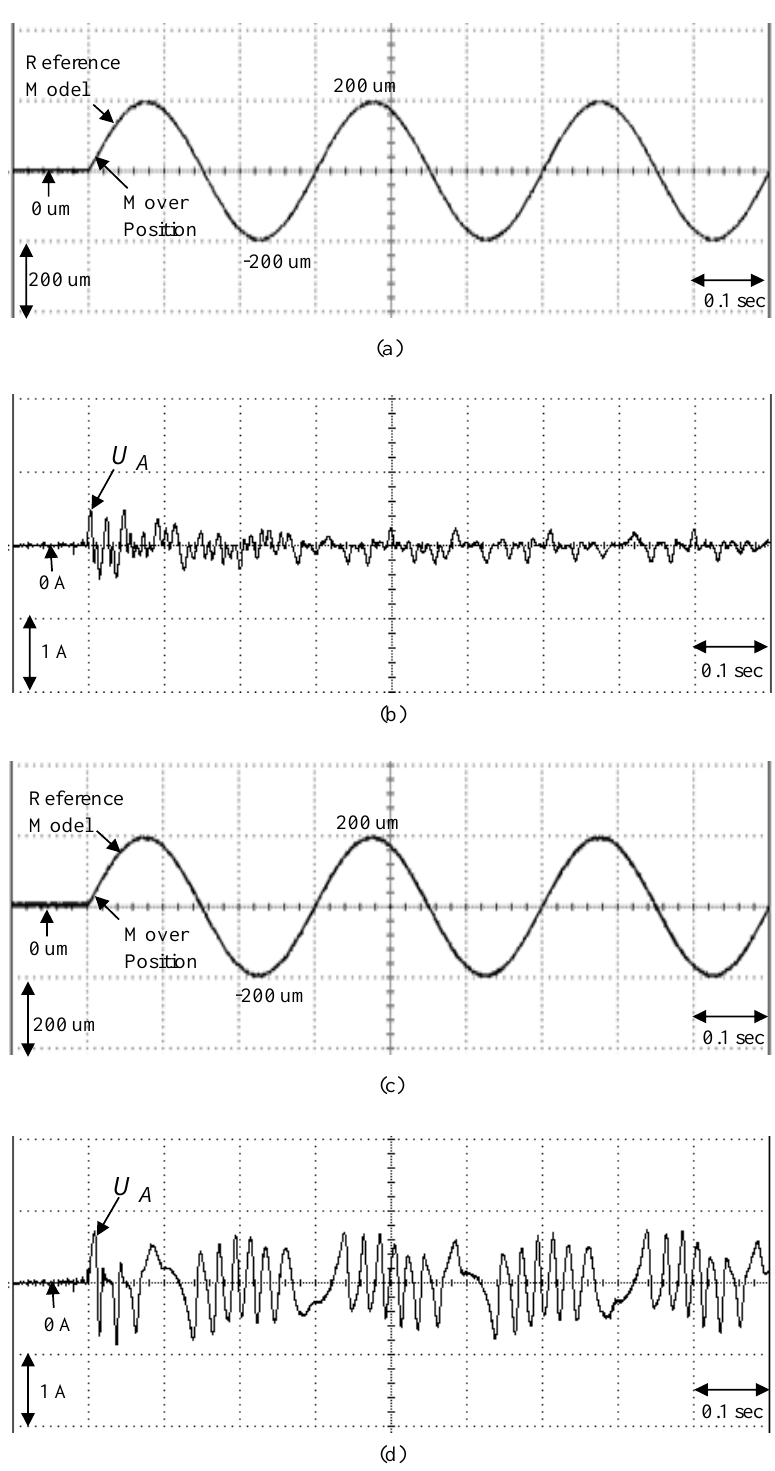
Figure 10. Experimental results of the micrometer backstepping control system using an amended recurrent Gottlieb polynomials neural network and AACO with the compensated controller for the periodic sinusoid command: ( a ) mover position in the rated case; ( b ) control intensity in the rated case; ( c ) mover position in the parametric variation case; ( d ) control intensity in the parametric variation case.